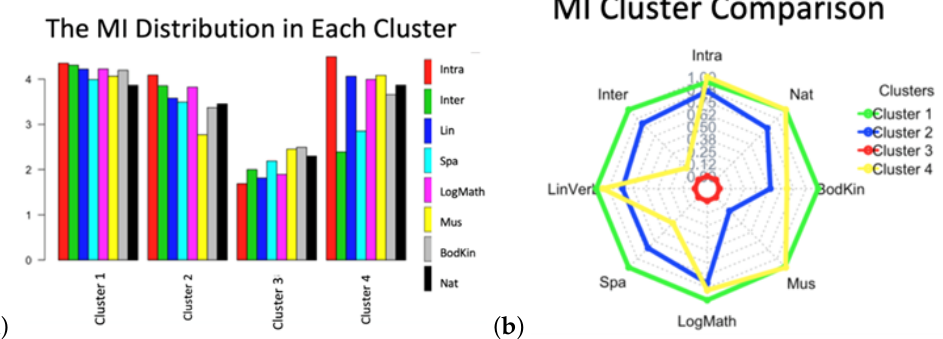
Figure 5. Comparison of MI clusters: ( a ) bar diagram; ( b ) normalized radar.